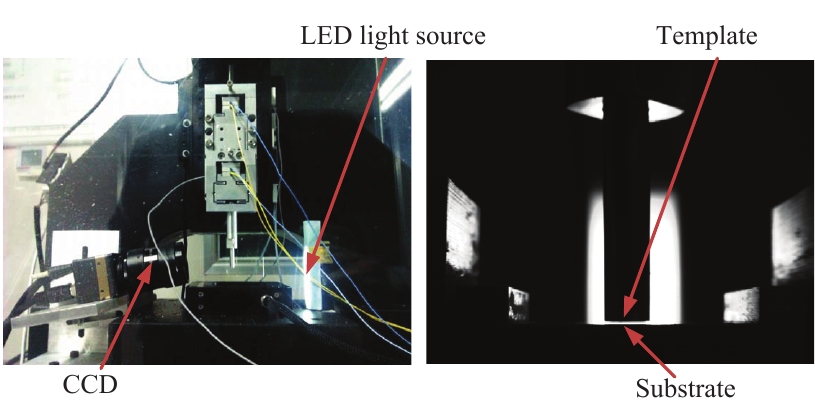
Figure 9. The visual sensing system.